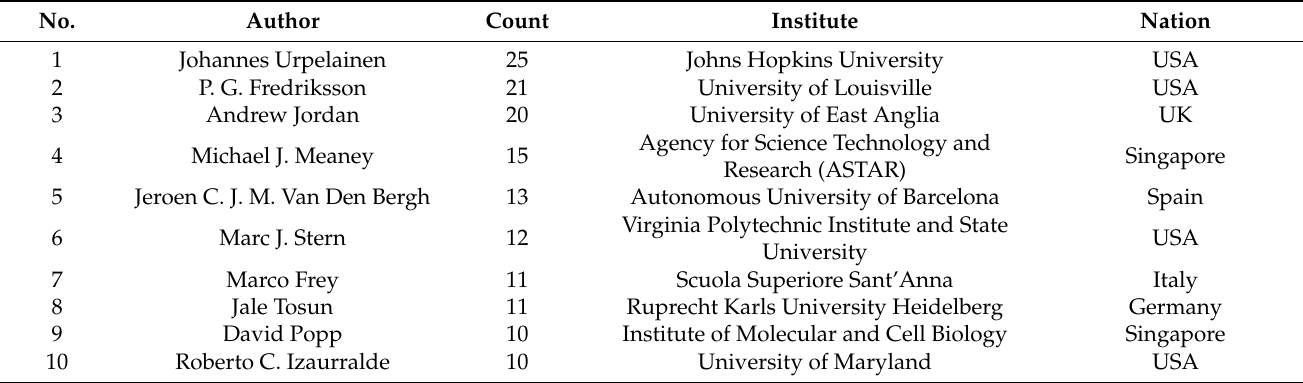
Table 4. Most contributing authors in research on environmental regulation from 2000 to